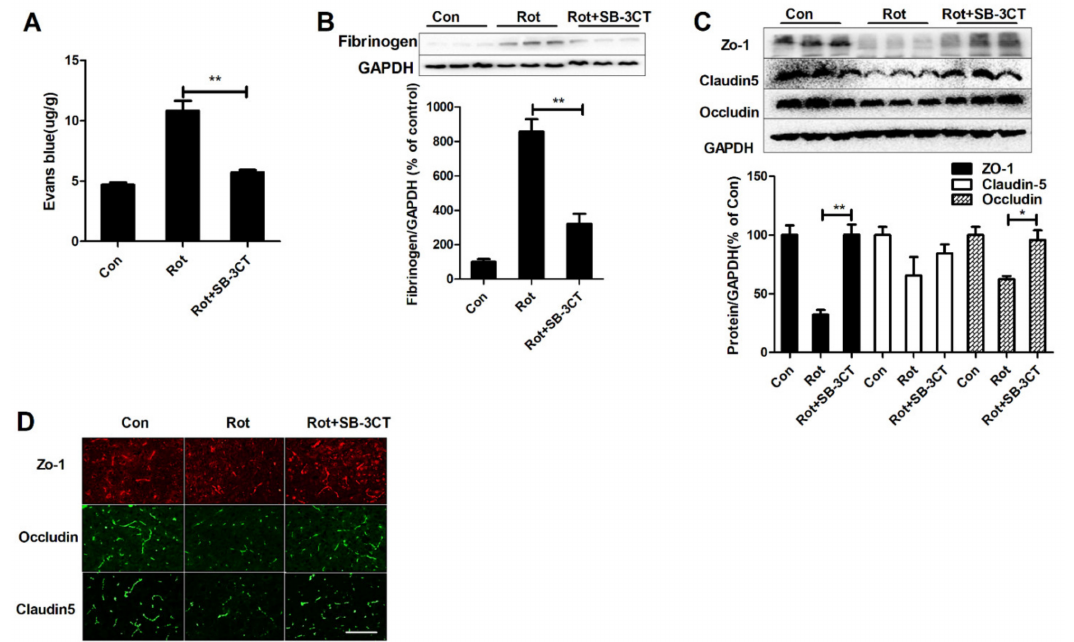
Figure 5. Inhibition of MMP-2/-9 by SB-3CT prevents BBB disruption in rotenone-lesioned mice. ( A , B ) The contents of Evans blue in mice for each group. n = 3. ( B ) Representative blots of fibrinogen in mice for each group and the quantification of blots. ( C ) Representative blots of ZO-1, occludin, and claudin-5 in mice for each group and the quantification of blots. n = 3. ( D ) Representative images of ZO-1, occludin, and claudin-5 staining in the SN of mice. n = 3. * p < 0.05, ** p < 0.01; scale bar = 50 µ m. Con: vehicle-treated mice group; Rot: 1.5 mg/kg/d rotenone-treated mice group; Rot + SB-3CT: 1.5 mg/kg/d rotenone + SB-3CT-treated mice